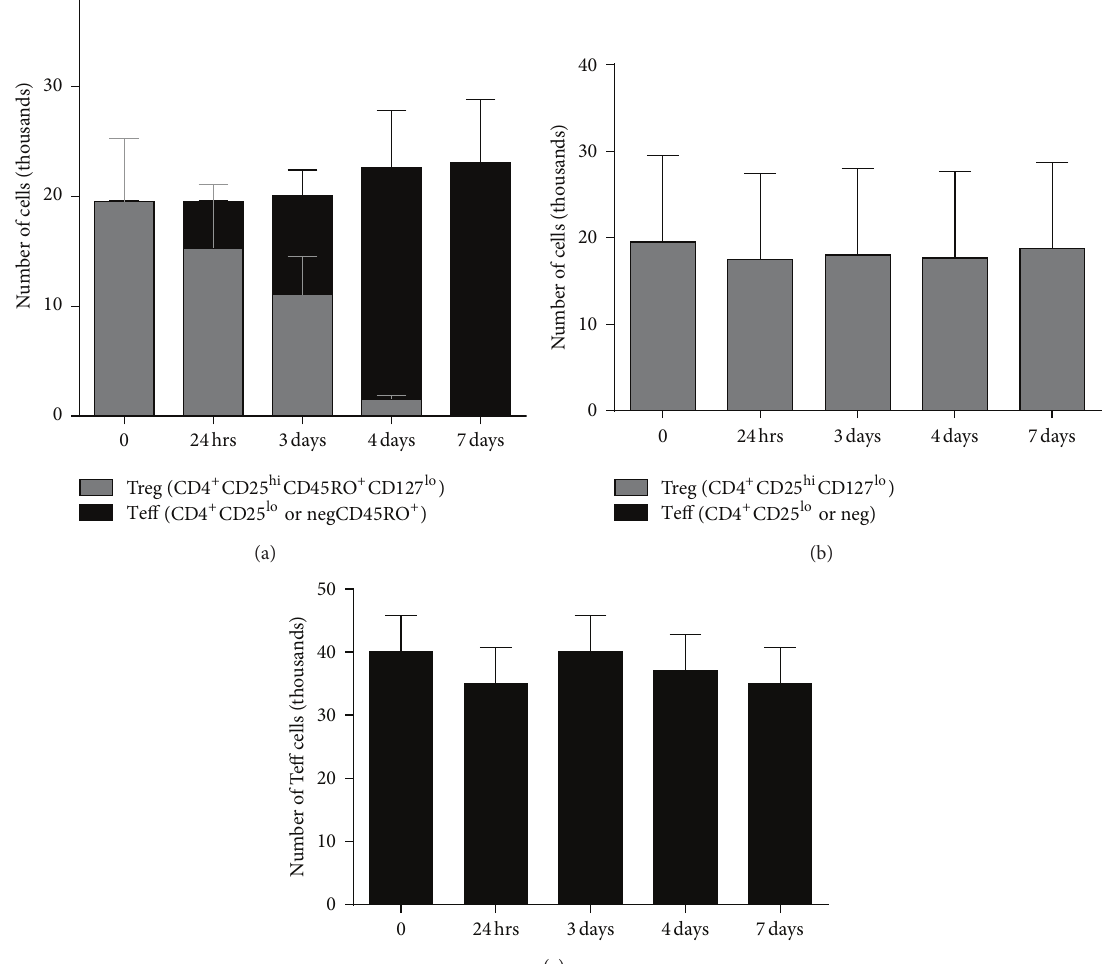
Figure 3: Phenanthrene exposure results in Treg to Teff conversion. Isolated Treg from individual healthy donors ( 𝑛 = 5 ) were incubated with 300 nM Phe for 0 to 7 days and analyzed for T cell phenotype. Cells were analyzed at 5 time points by immunophenotyping for Treg (CD4 + CD25 hi CD127 lo , gray bars) and Teff (CD4 + CD25 neg/lo , black bars) subsets in cultures exposed to Phe (a) versus diluent alone (b). Teff incubated with Phe did not show decreases in cell number over time (c). Error bars show